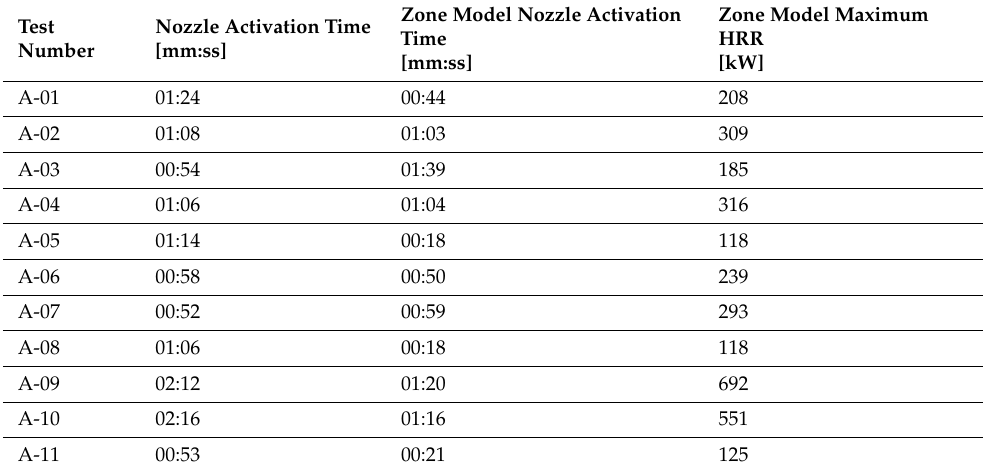
Table 3. Nozzle activation times and maximum HRRs estimated in the zone